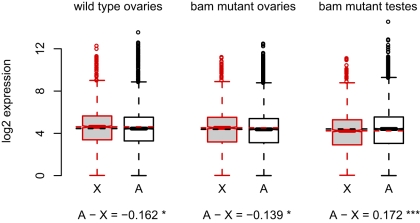

X chromosome and autosome expression is similar in ovaries and germline stem cells.RNA-seq data [48] from wild-type ovaries, bam mutant ovaries, and bam mutant testes. * p<0.05, *** p<0.001 (Mann-Whitney test).